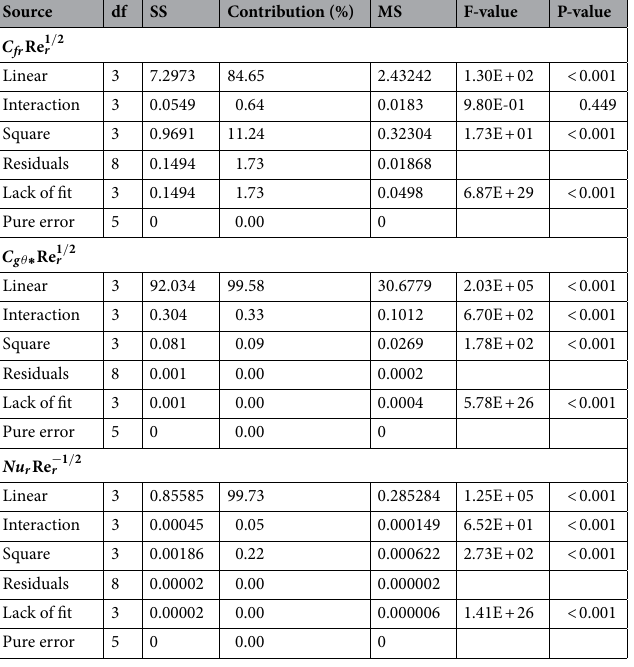
) and the local Nusselt number ( Nu x ) is presented, ∗